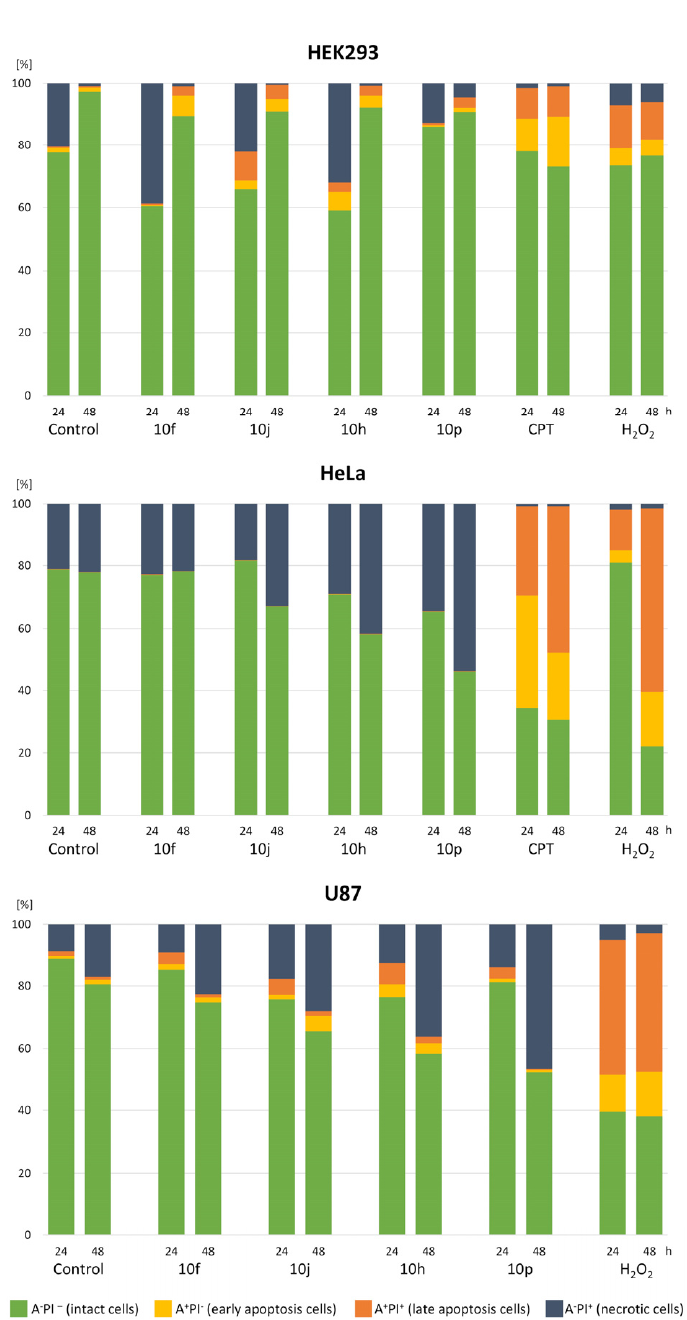
The investigated compounds crystallized in the monoclinic P 2 1 / c ( 11 *TsOH, 13i , 14c , 10b , 10g , 10l , and 10m ) or C 2 / c ( 10i ), orthorhombic P 2 1 2 1 2 1 ( 10h ) or Pbca ( 10o ) and triclinic P -1 ( 10j ) space groups, with one molecule of a compound in the asymmetric unit of the crystal lattice (Figure 4, Figures S1 and S2). The asymmetric unit of 10b contains one molecule of solvent (acetone). The conformation of 10a-o resembles a butterfly. The refinement parameters and details of the crystallographic data are presented in Table S1 (ESI). The values of valence and torsion angles, together with bond lengths are presented in Tables S2 − S4 (ESI).